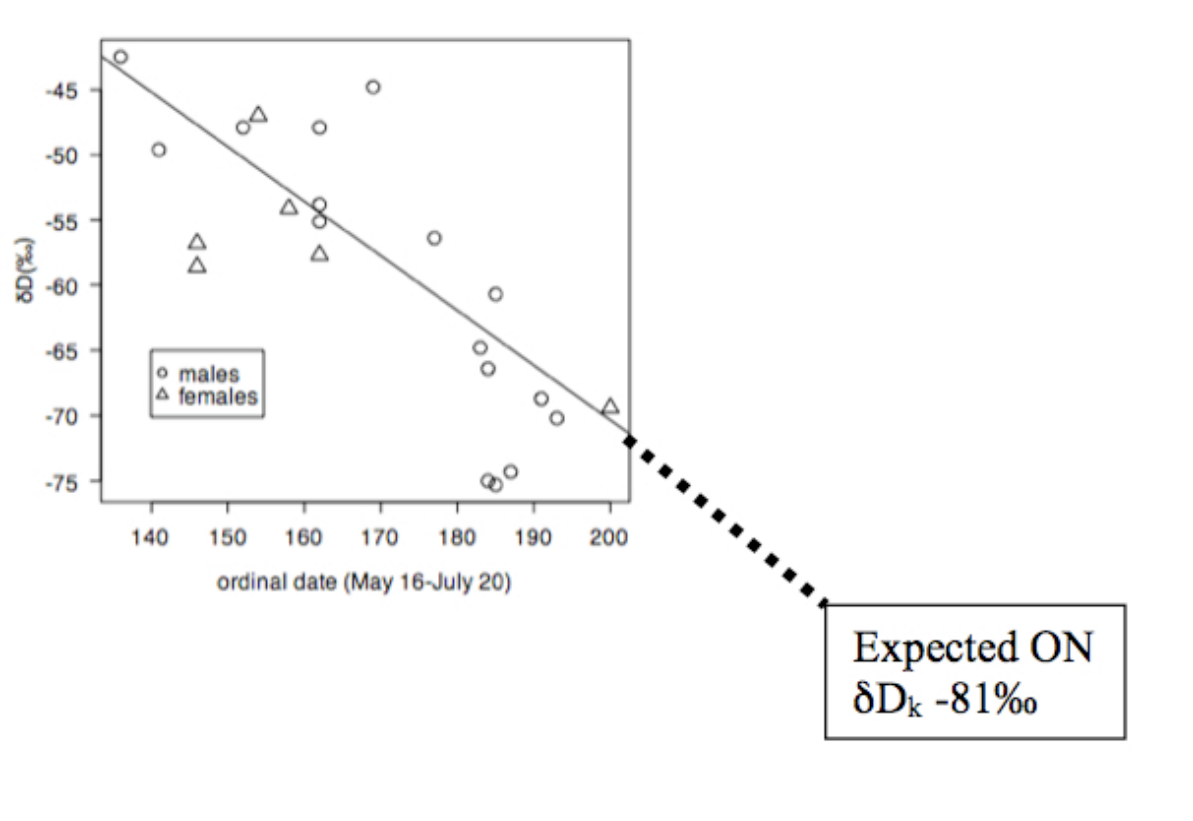
Fig. 2. The relationship between d D values in claws of Cerulean Warblers collected in Ontario (females k n = 6, males n = 16) and ordinal date. There was no significant difference between the rate of d Dk change for breeding Golden-winged and Cerulean Warblers. The solid line represents a least-squared linear